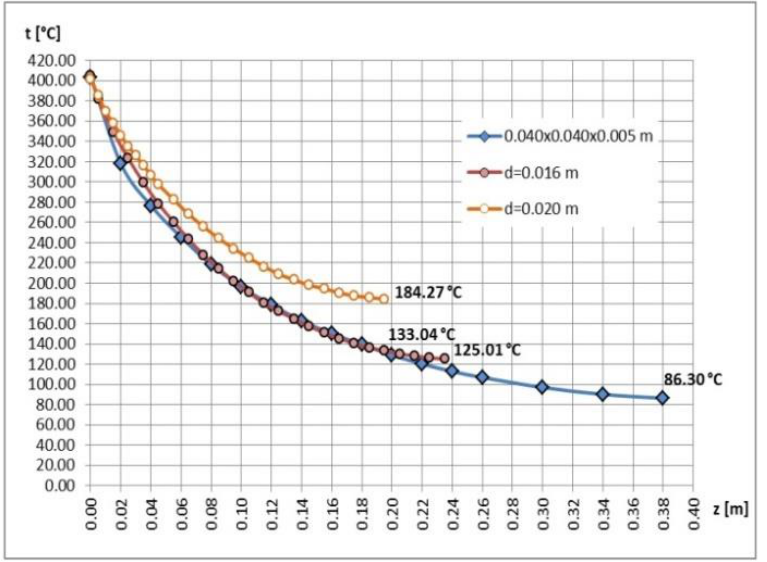
 and 𝑡 𝑂,𝑛 =  and 𝑡 𝑂,𝑛 = g g